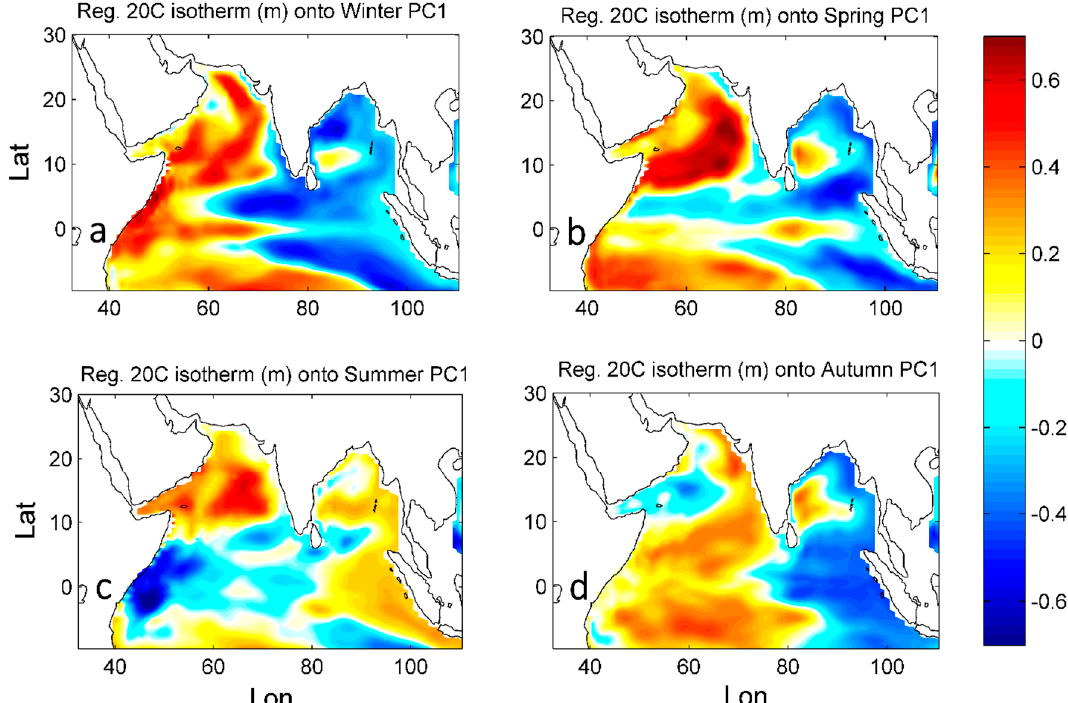
Figure 7. Same as in Figure 6, but for the thermocline depth denoted by 20 °C isotherm. Zero lines are omitted.